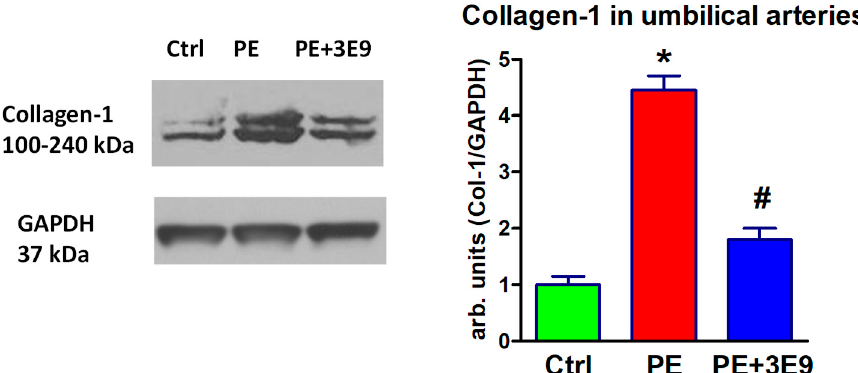
Figure 3. Western blots of collagen-1 in umbilical arteries from normotensive pregnant control subjects (green column; Ctrl), patients with PE (red column, PE), and patients with PE incubated with 3E9 anti-marinobufagenin antibody (blue column, PE + 3E9). Left, representative Western blots; right, bars representing means ± SEM from 4 densitometry measurements. By 1-way ANOVA followed by Neuman-Keuls test: * p < 0.01 vs. Ctrl; # p < 0.05 vs. PE. Levels of collagen-1 were normalized against levels of GAPDH.